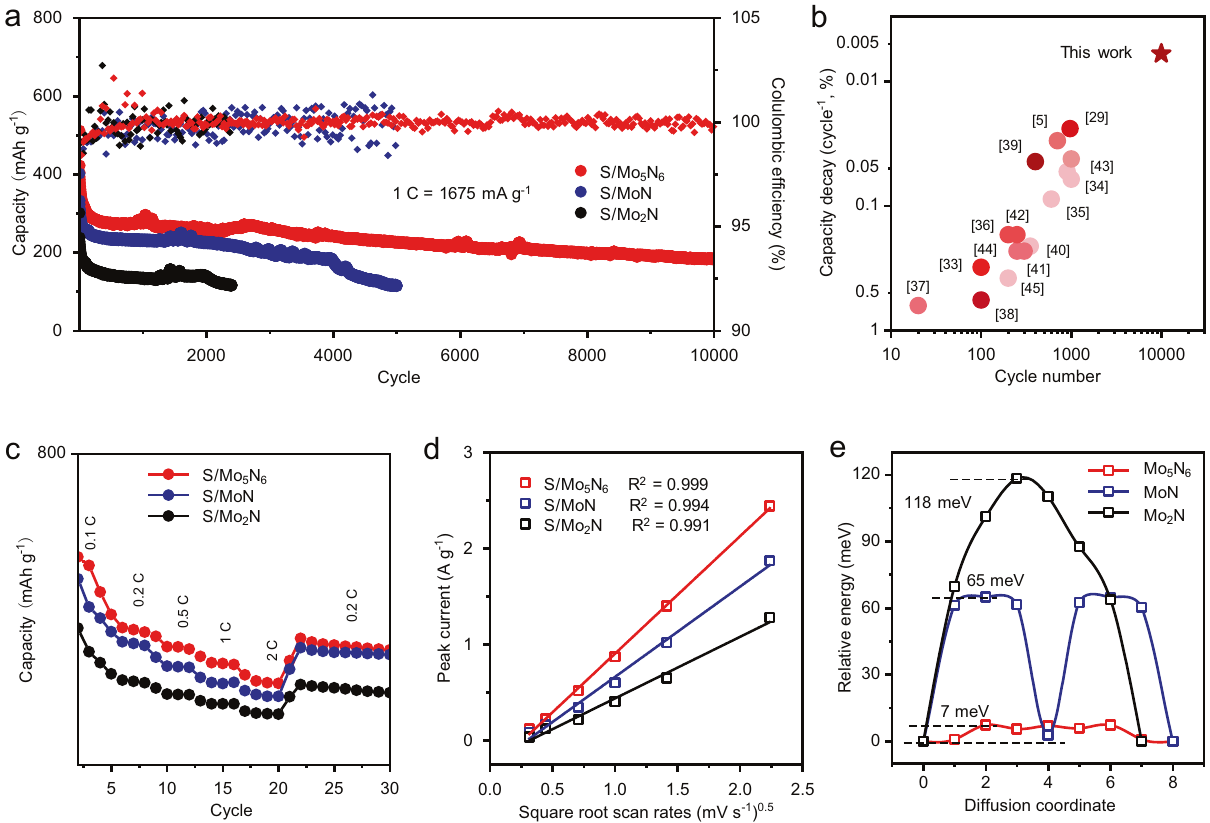
Fig. 2 Electrochemical properties of the molybdenum nitrides in RT Na – S batteries. a Cycling performance and CE for the three sulfur electrodes at 1 C. b Comparison of cycle number and capacity retention of recently reported RT Na – S cells with the present work, in which darker-color refers to greater speci fi c current. c Rating capacities for S/Mo 5 N 6 , S/MoN, and S/Mo 2 N. d Linear relationship between peak current ( i p ) and square root of scan rate ( v 1/2 ) for the three sulfur electrodes. e Energy pro fi le for sodium ion diffusion on Mo 5 N 6 (0 0 4) facet, MoN (0 0 2) facet, and Mo 2 N (1 0 0)